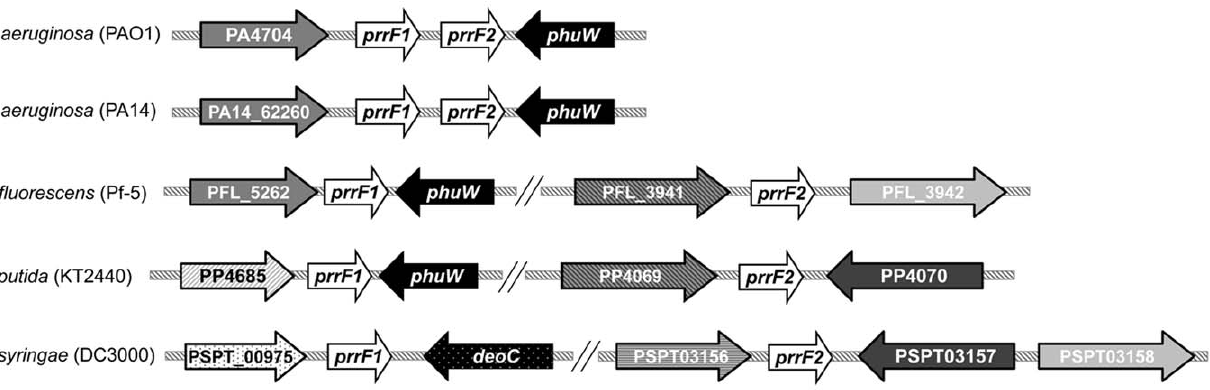
Figure 1. Genetic organization of prrF regions from different Pseudomonads. The tandem gene organization of prrF1 and prrF2 is restricted to P. aeruginosa strains. Block arrows indicate directionality of the open reading frame, and orthologous genes are represented by the color and pattern of the arrow. Map not drawn to scale.